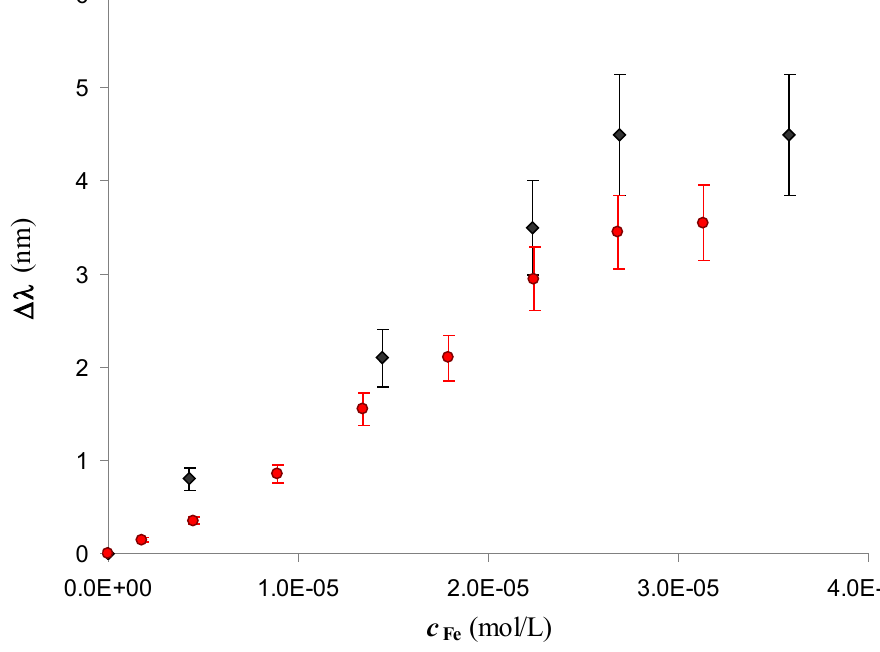
Figure 3. Standardization curves of Fe(III) on two DFO-SAM-POF sensors. Fe(III) standard solutions in 0.5% HNO (pH = 1.1). 20–40 µl of the standard solution are dropped 3 over the gold layer of the sensor, and the transmission spectra are recorded after 5 min incubation. Experiments performed with two different sensors: DFO-SAM-POF (black diamonds); DFO-SAM-POF (red circles). The error bars correspond to the standard deviation of three replicates for each standard